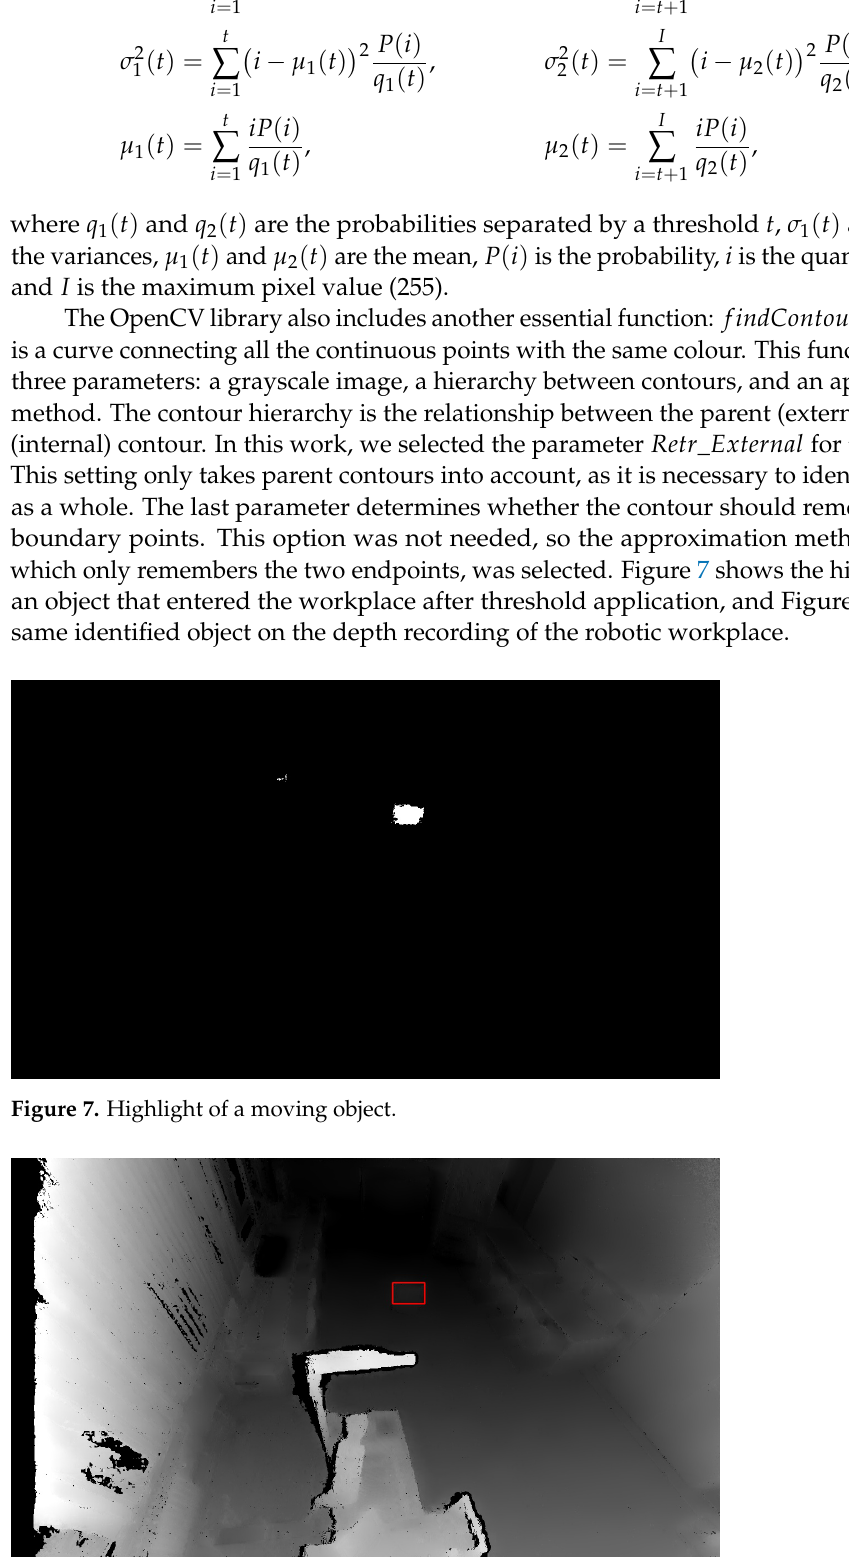
Figure 8. Marked and identified object on the depth image. The red rectangle represents an identified object based on depth